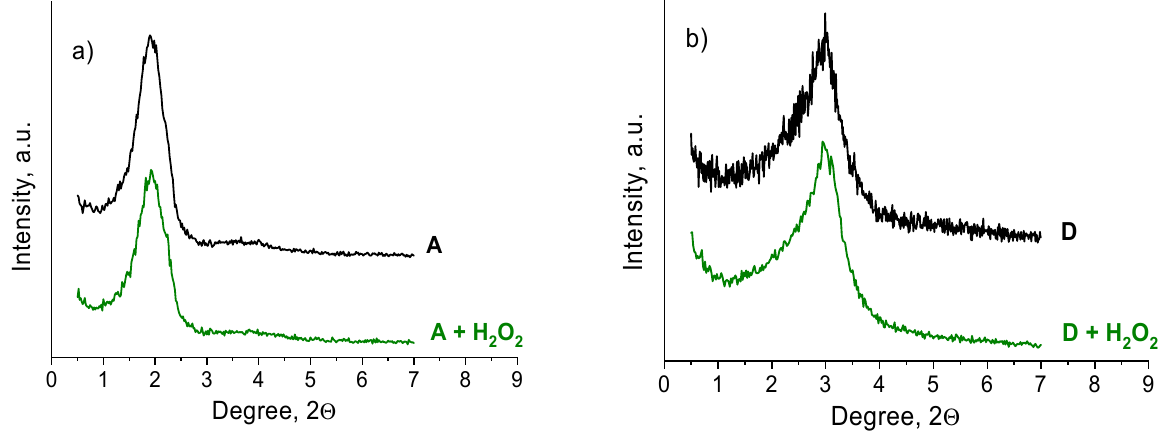
Figure 15. XRD patterns of samples ( a ) A and ( b ) D : initial and after treatment with H 2 O 2 in MeCN.